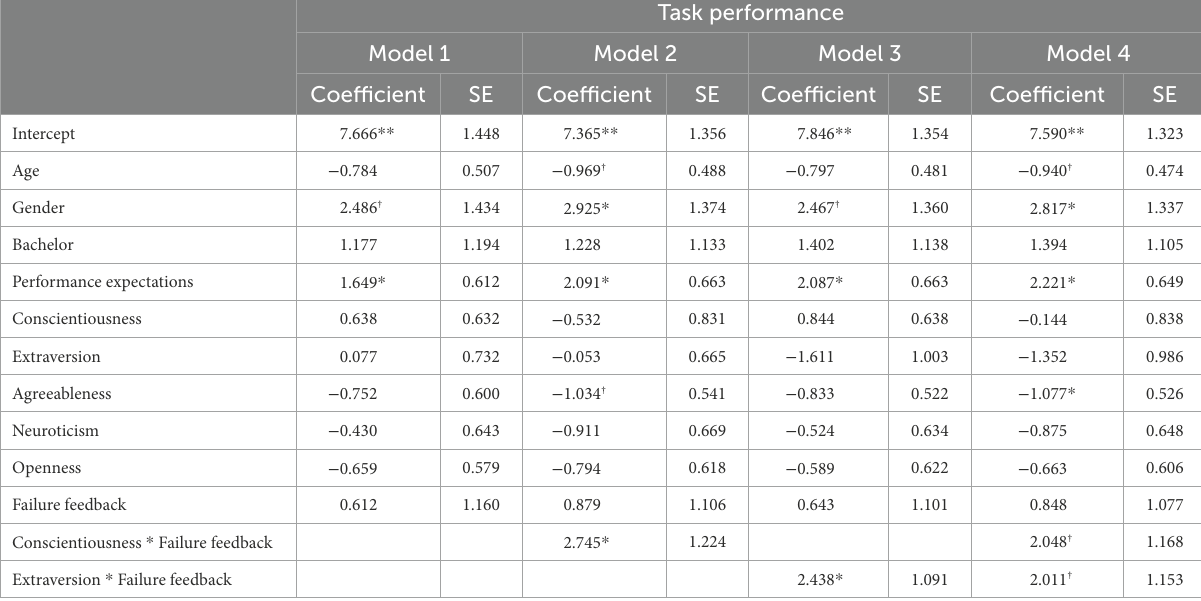
TABLE 2 Results from analyses.